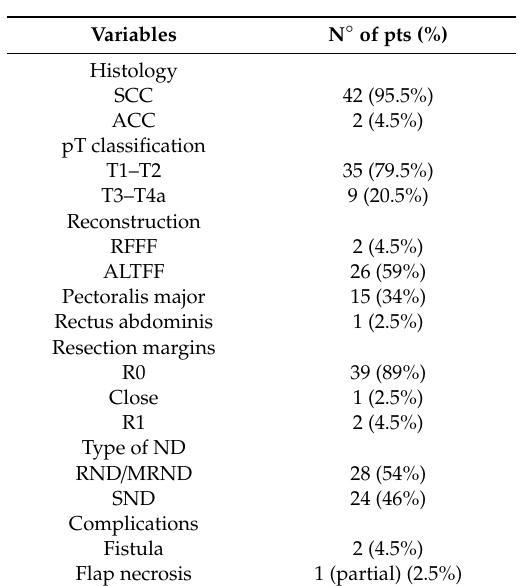
Table 1. Patient data.